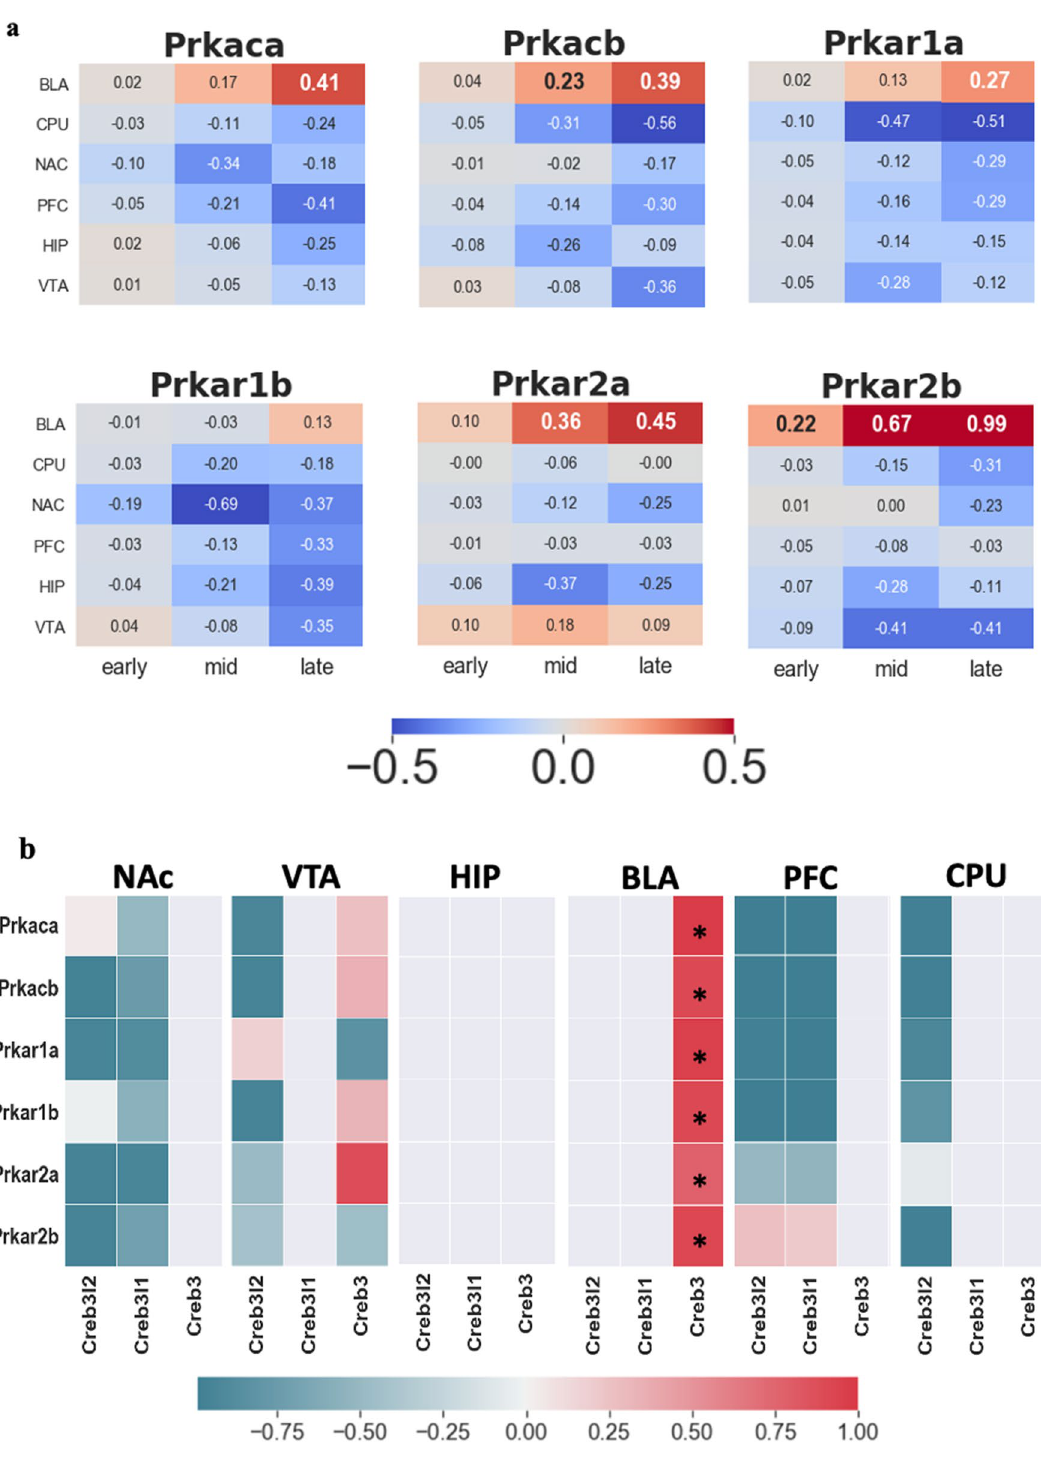
p-eIF2a , an indicator of the inhibition of general translation, is normally accompanied by upregulation of Atf4 . Many previous studies have reported a significant relationship between p-eIF2a and Atf4 67,68 . Especially, Perk-p-eIF2a − Atf4 is a well-known pathway involved in ER stress. However, strikingly, our results showed